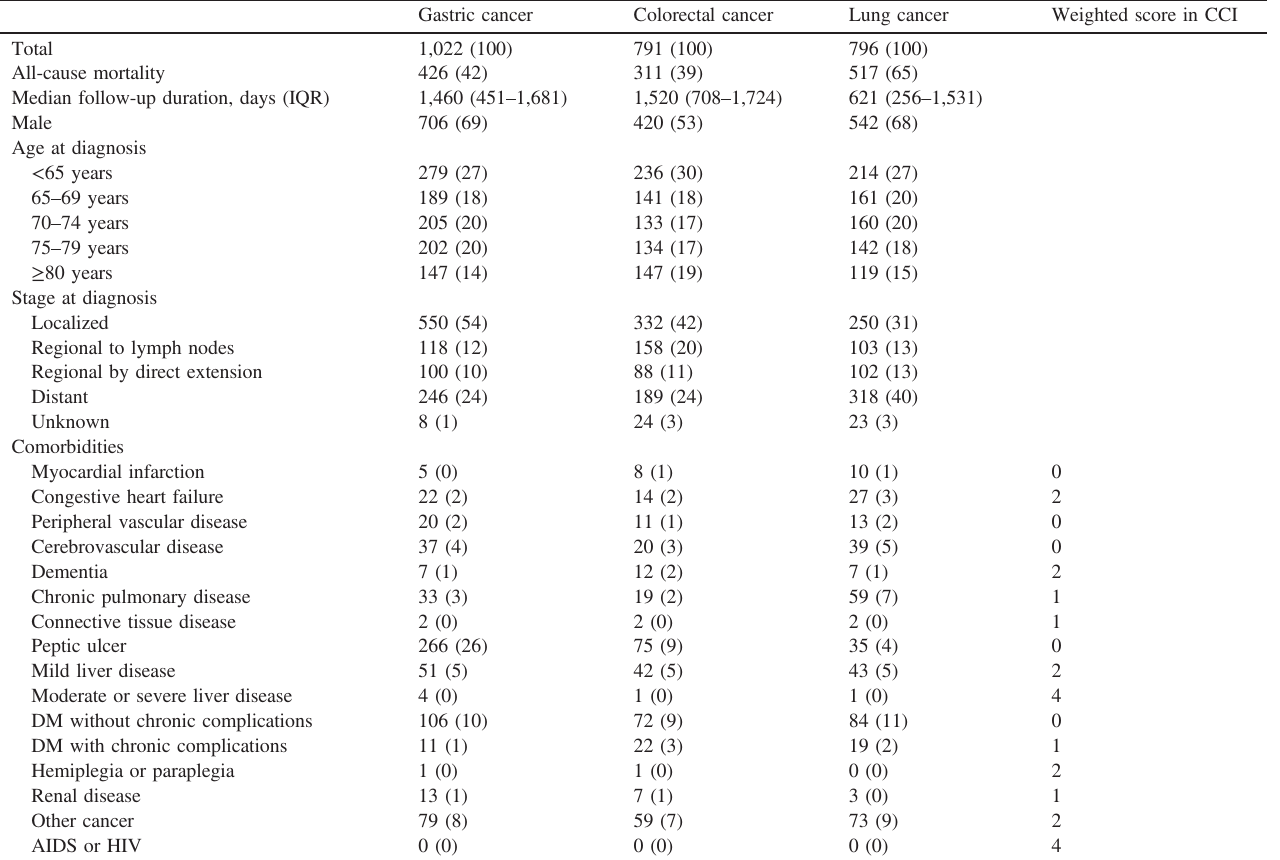
Table 1. Patient characteristics and prevalence of comorbidities Gastric cancer Colorectal cancer Lung cancer Weighted score in